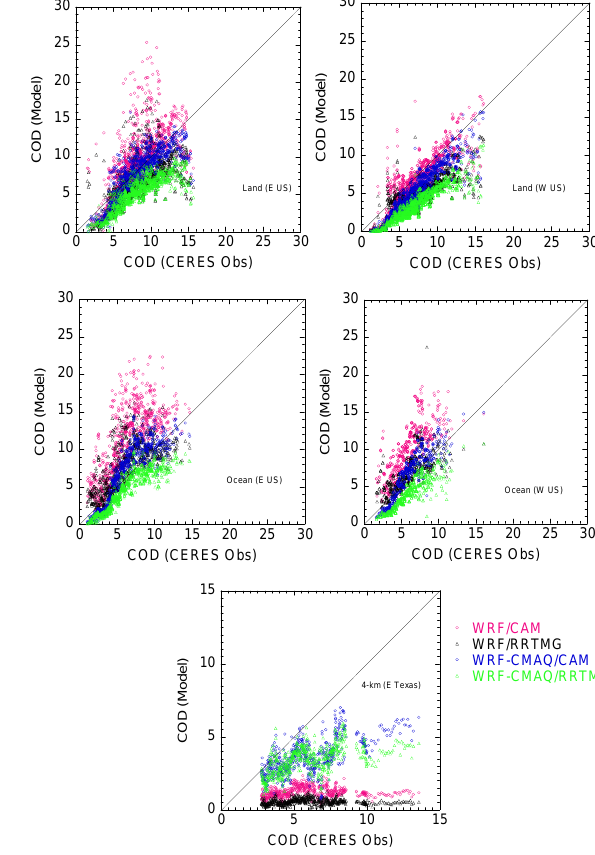
Figure 20. Same as Figure 11 but for COD for August of 2006. Figure 21. Same as Figure 11 but for COD for September of 2006.